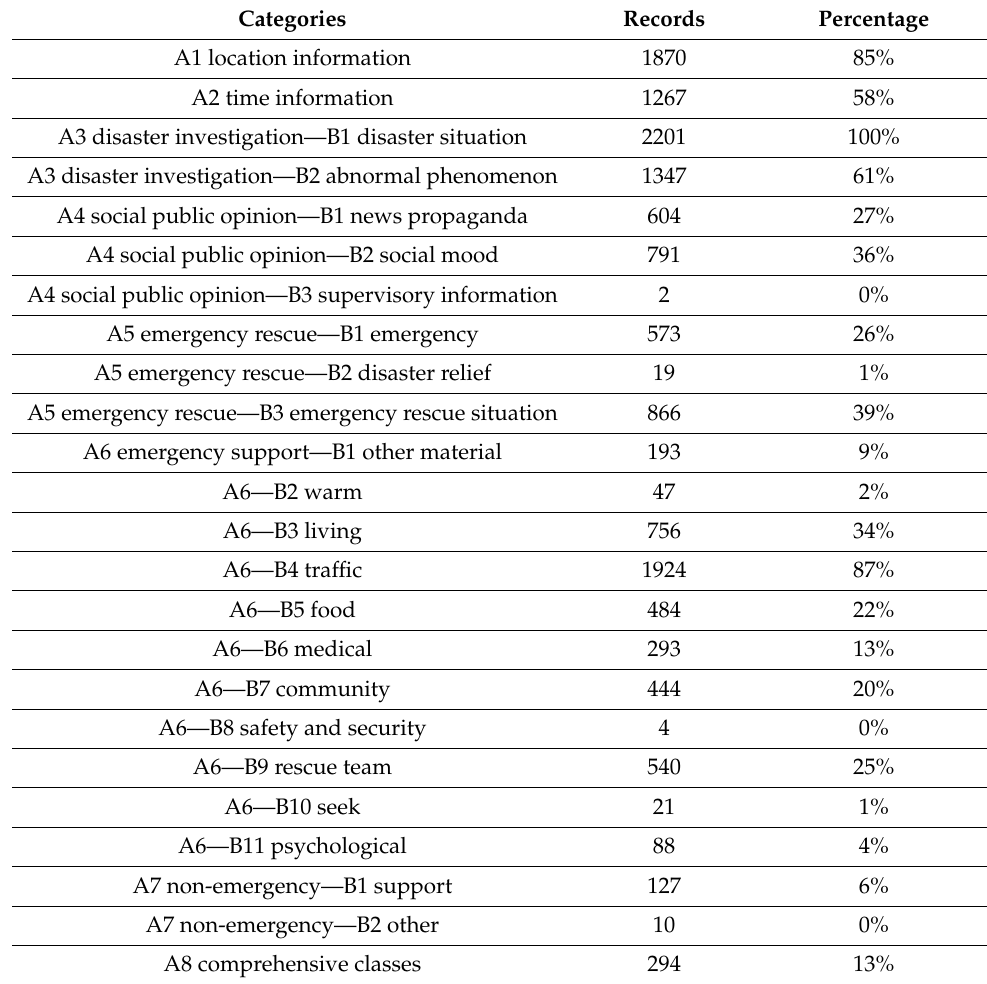
Table 7. Results of the information classification validity